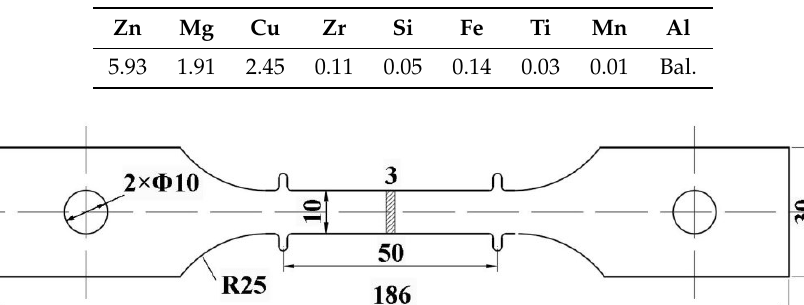
Table 1. Nominal chemical composition of AA7050 (wt. %).